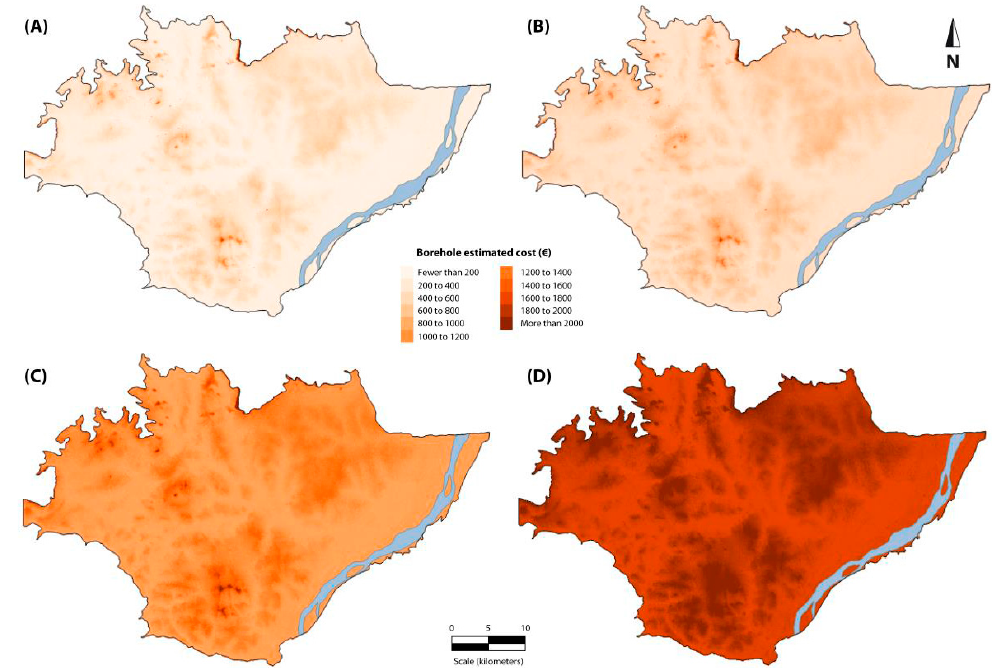
Figure 13. Approximate cost of a fully equipped borehole. Results include salaries, materials, casing, development, and pump cost and installation, but do not consider amortization. ( A ) Two-inch diameter, homemade pump; ( B ) four-inch diameter, homemade pump; ( C ) four-inch diameter, standard hand-pump; ( D ) four-inch diameter, standard solar pump with panels.